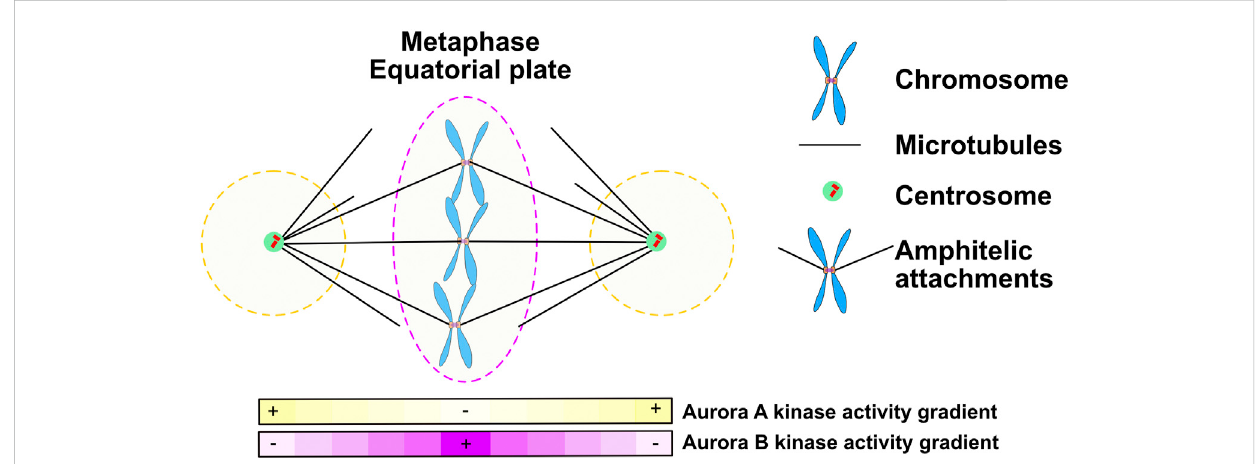
FIGURE 5 During prometaphase and metaphase Aurora A forms gradients at the poles of the mitotic spindle while Aurora B moves with chromosomes to the metaphase plate and may set up a central gradient. Figure representation: Spindle poles, green circle; Chromosome arms, Blue; Kinetochores, Orange rectangles;Microtubules, Blacklines;AuroraAkinaseactivitygradientwithindashedblacklines;Ampitelicattachments;twosisterkinetochoresattached by microtubules from opposite poles; Aurora B kinase activity gradient within dashed red lines; Pink heat map represents Aurora B kinase activity gradient; Yellow heat map represents Aurora A kinase activity